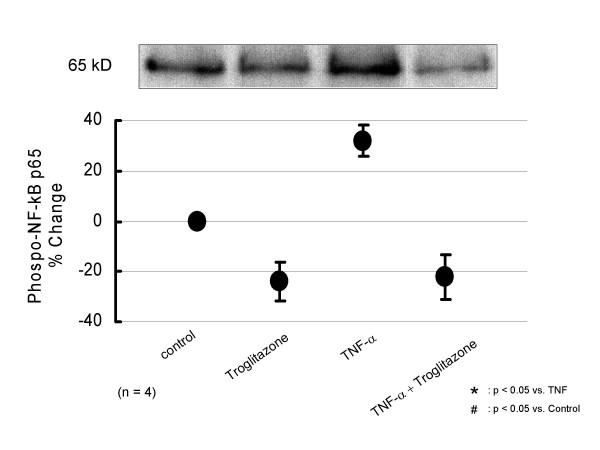
TNF-α induced phosphorylation of NF-kB p65 is prevented by troglitazone, a PPAR-γ ligand. TNF-α (1 ng/ml, 1 h) induced phosphorylation of NF-kB p65 was significantly attenuated by the PPAR-γ ligand, troglitazone (20 μM). Alone, troglitazone also attenuated phosphorylation of NF-kB p65.